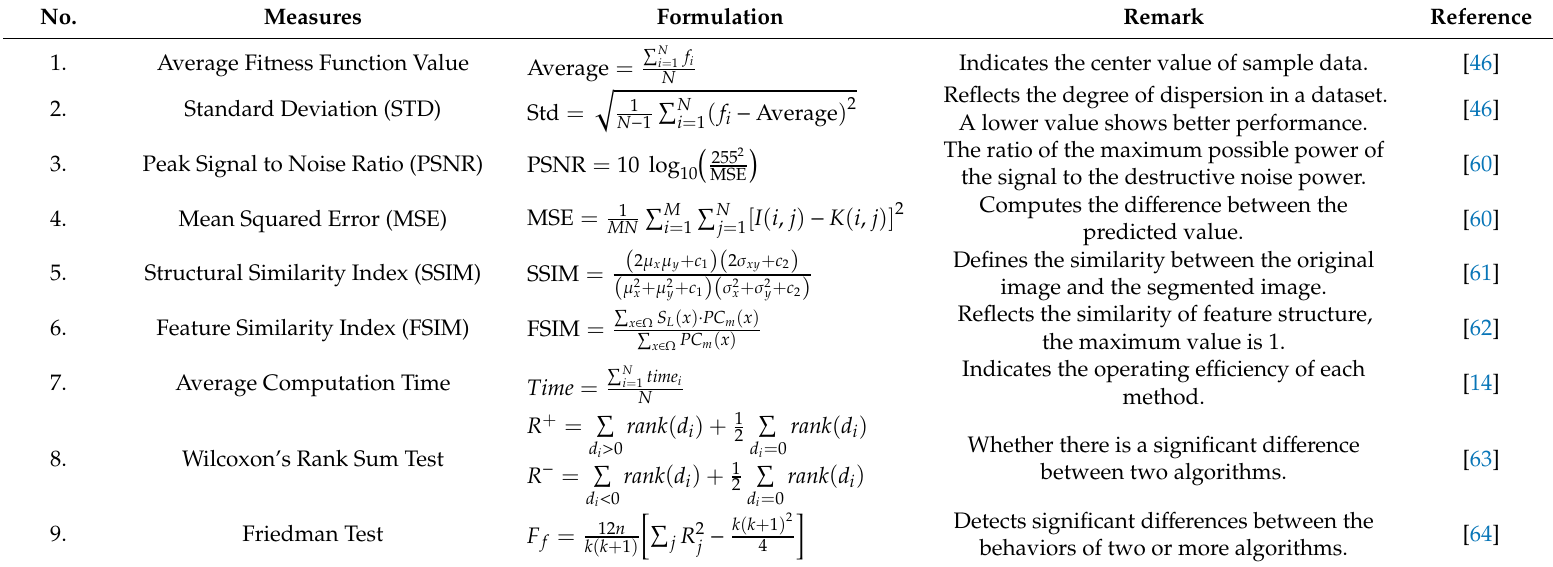
Table 4. Performance measures of the multilevel image segmentation